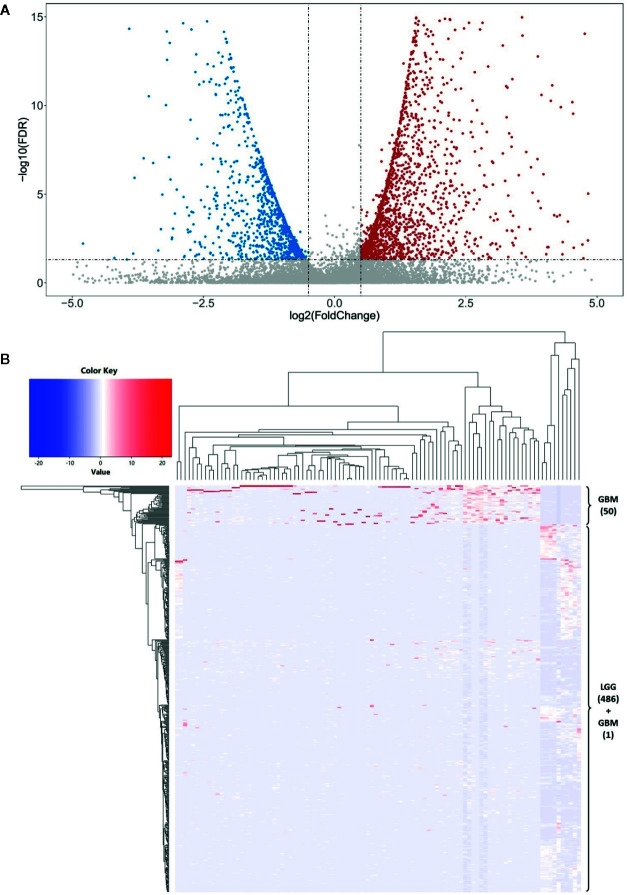
The differential expression analysis of lncRNAs. (A) The volcano plot shows a profile of the expression of all these lncRNAs in this study. There are 1,284 highly expressed (i.e. and FDR p < 0.05) and 704 lowly expressed lncRNAs (and FDR p < 0.05) in the GBM subjects. (B) The clustered heatmap of the top 100 most differentially expressed lncRNAs between LGG and GBM subjects. Most of these lncRNAs (83%) are significantly highly expressed in the GBM than LGG subjects. There are 50 GBM subjects (about 98.04%) grouped into a cluster base on the lncRNA expression.